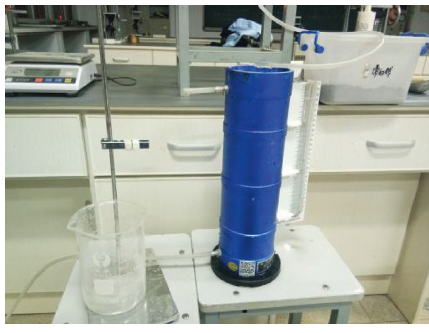
Figure 4: TST-70-type